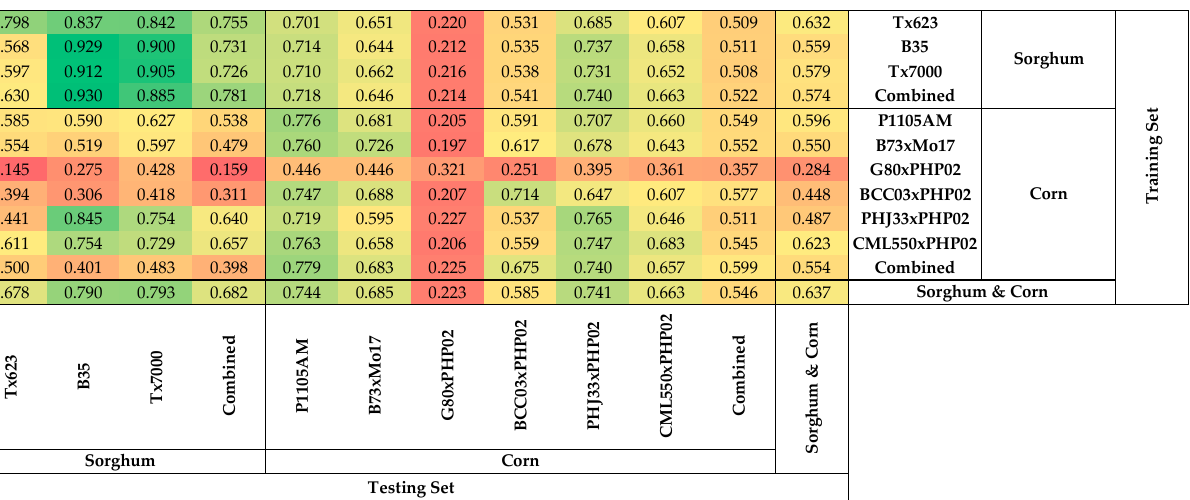
Figure 4. Coefficients in models predicting the relative water content with the responses of combined sorghum or combined corn.